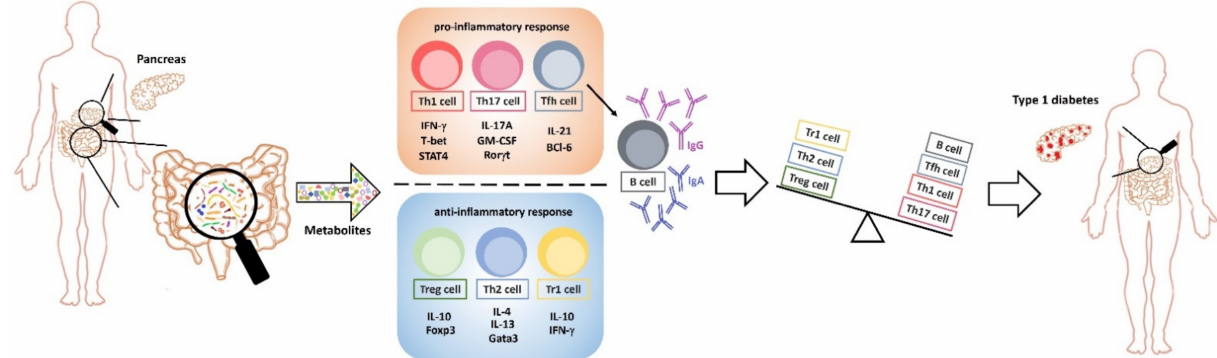
Figure 2. Gut microbiota-modulated regulation of the damage of pancreatic tissues by adaptive immune cells. The production of cytokines by distinct T helper cells are indicated in components involved in regulating Th1, Th2, Th17, Tfh, Treg, and B cells. These pro-inflammatory cytokine-producing Th subsets include T-bet/STAT4-mediated Th1 (interferon (IFN)- γ ), Ror γ t-modulated Th17 (IL-17A, GM-CSF), and BCL-6-mediated Tfh (IL-21), whereas these anti-inflammatory cytokine-secreting Th subsets are Gata3-modulated Th2 (IL-4, IL-13), Foxp3-mediated Treg (IL-10), and Tr1 (IL-10, IFN- γ ) cells. The networks of cytokines in pancreatic tissues affected by gut microbiota regulate the development of adaptive immune